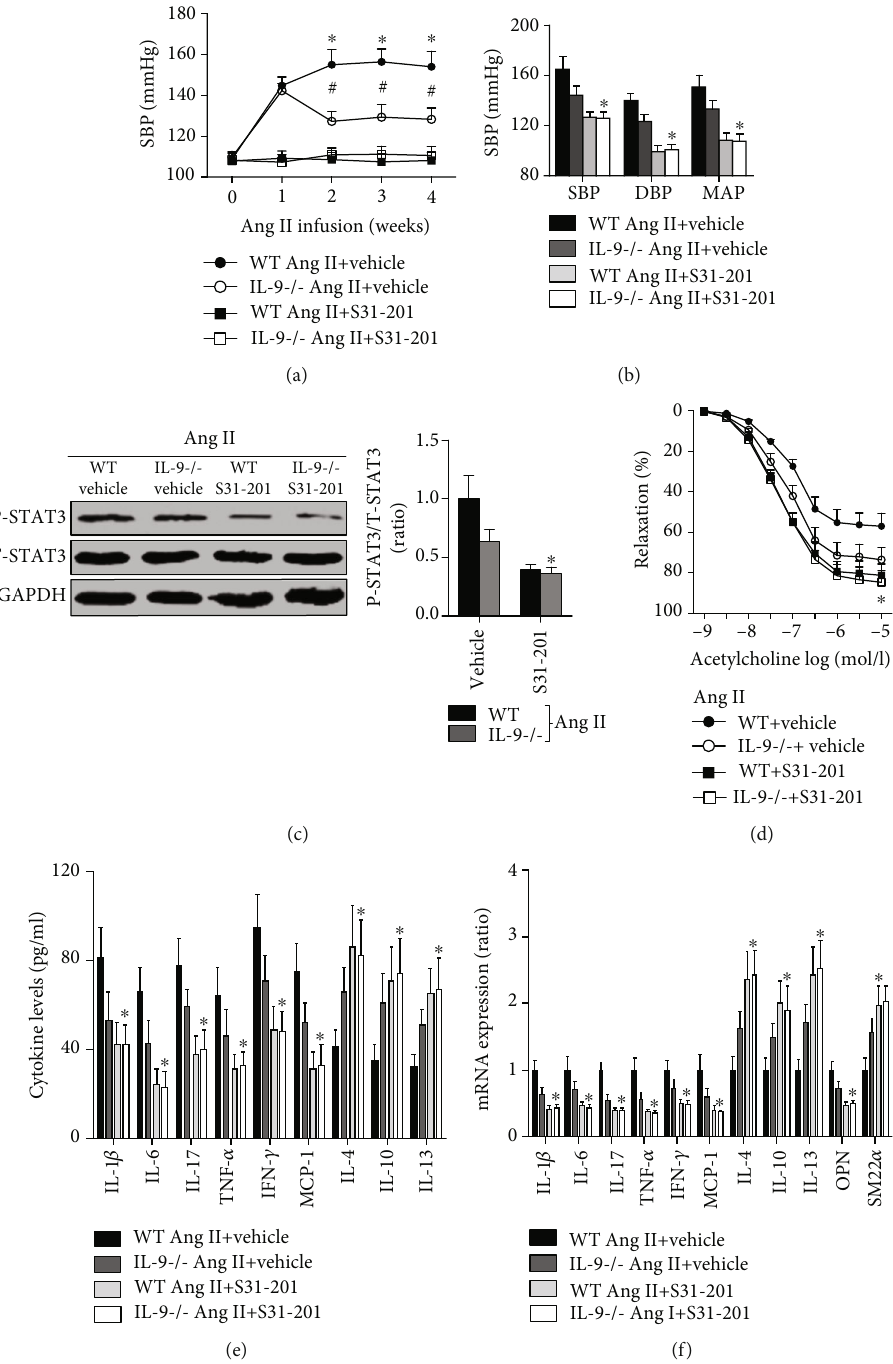
Figure 6: E ff ects of S31-201 on blood pressure, in fl ammation, and phenotypic transformation of smooth muscle. (a, b) Blood pressure was determined using the tail-cu ff method and the Millar Pressure Volume System; N = 10 in each group. (c) The STAT3 phosphorylation in each group was measured. (d) The vascular function for the four groups was detected. (e) Serum cytokine levels were measured using ELISA kits. (f) Aortic mRNA expression of cytokines was analyzed by RT-PCR. N = 5 in each group; ∗ p < 0 : 05 vs. the IL-9-/- Ang II+DMSO